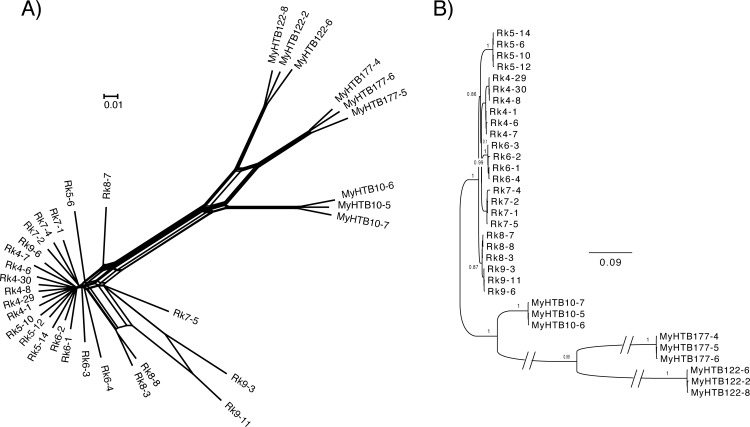
(A) Phylogenetic network analyses based on SNPs in the genome of S. stercoralis. (B) A maximum likelihood tree of SNPs in the mitochondrial genomes of S. stercoralis samples. The scale bars show the number of nucleotide substitutions per site. Branches marked with \\ indicate a two-fold shortening of branches (only for practical purposes).